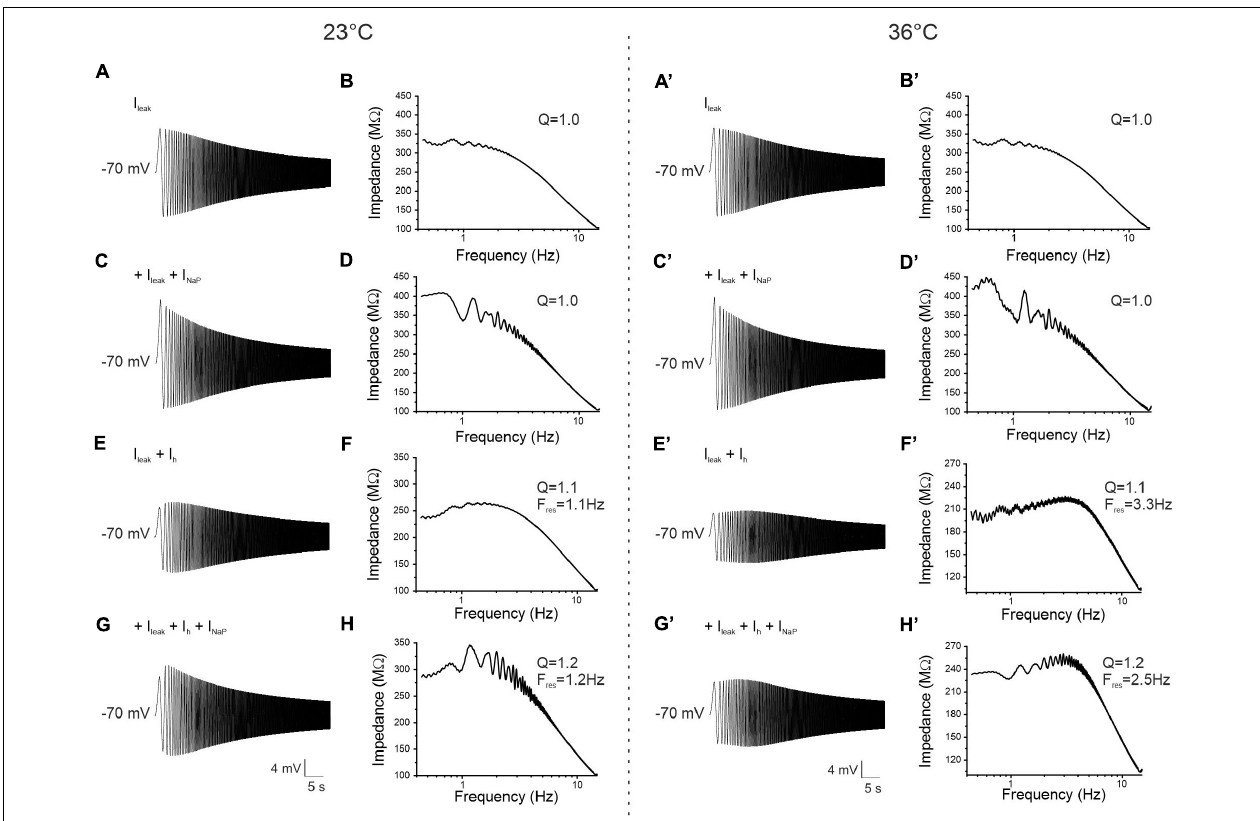
FIGURE 11 | Computational MATLAB model reflecting experimental data and simulating resonance. (A) Voltage response to the 0–15 Hz ZAP input at –70 mV and 23 ◦ C simulated by a model including only the leakage current (I leak ). (B) Impedance-to-frequency relationship obtained from simulation in (A) . The behavior strongly resembles that of an experimentally recorded non-resonant neuron. (C,D) Same as (A,B) , but with the insertion of the persistent sodium current (I NaP ) in the model. The voltage response (C) and the corresponding impedance-to-frequency relationship (D) still resemble that of a non-resonant neuron. (E,F) Same as (A,B) , but with the insertion of a HCN channels-mediated current (I h ) in the model. The voltage response (E) and the corresponding impedance-to-frequency relationship (F) show that in these conditions the model is able to simulate resonant behavior. (G,H) Same as (A,B) but with the insertion of both I h and I NaP in the model. The voltage response (G) and the corresponding impedance-to-frequency relationship (H) show that this model not only resonates, thanks to I h , but it also displays a resonance amplified by I NaP . (A (cid:48) –H (cid:48) ) Same as (A–H) , but after setting the value of temperature at 36 ◦ C instead of 23 ◦ C in the model. Note that in the resonant model at the higher temperature (E (cid:48) –H (cid:48) ) the Q -value remains constant while the F res increases, as experimentally found. Model parameters are shown in Table 1